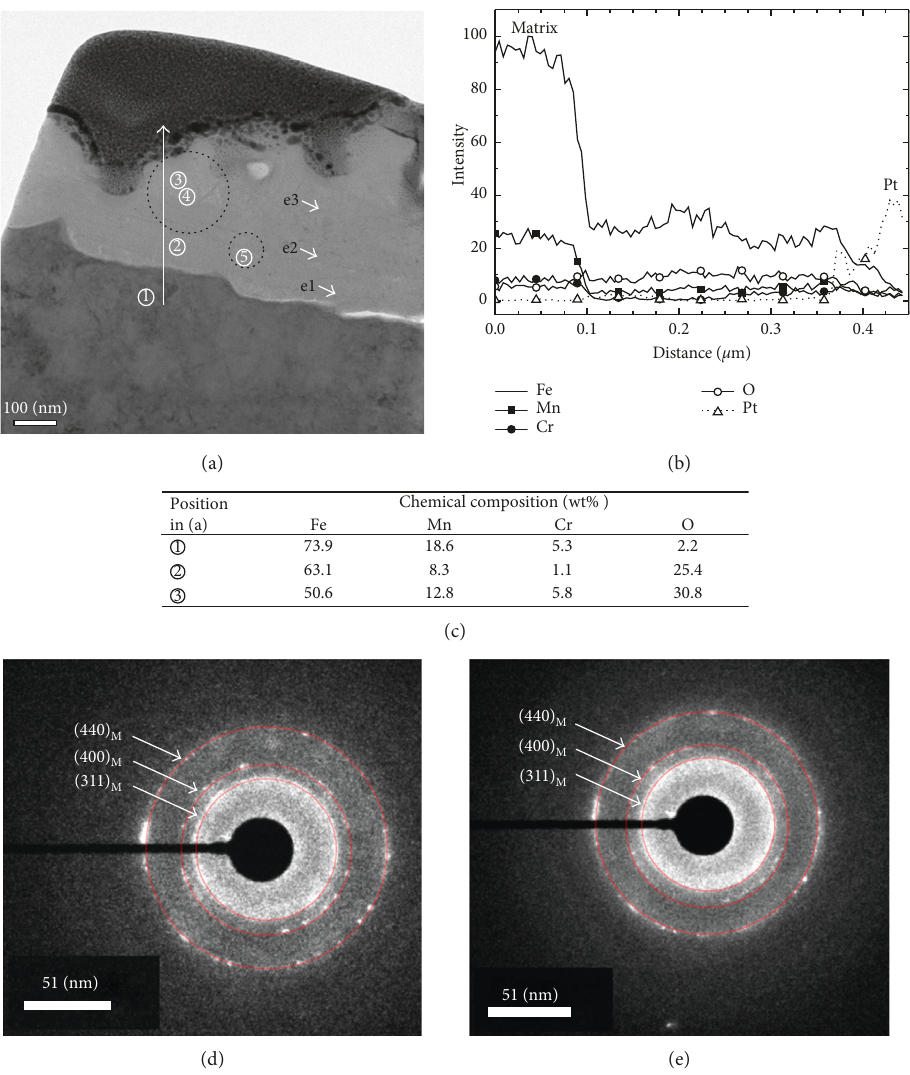
Figure 8: Cross-sectional TEM image (a), EDS line profile (b), EDS quantitative analysis of selected points 1, 2, and 3 (c), and SAEDs (d-e) of regions 4 and 5 in rust formed during 56-day immersion of 18Mn5Cr in 3.5% NaCl solution at 60 ° C, where subscript M indicates